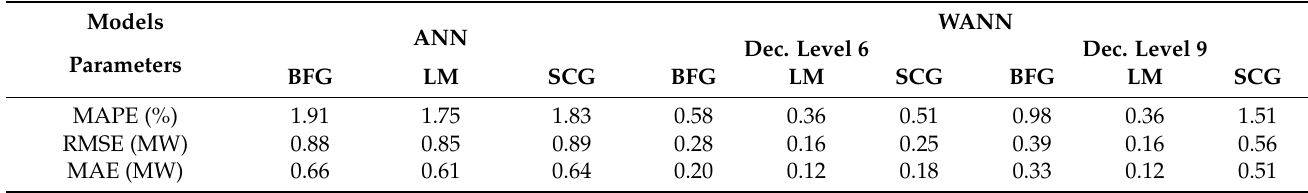
Figure 11. Comparison of reconstructed WANN and ANN (1 h ahead). Table 5. Errors obtained by ANN and WANN models.